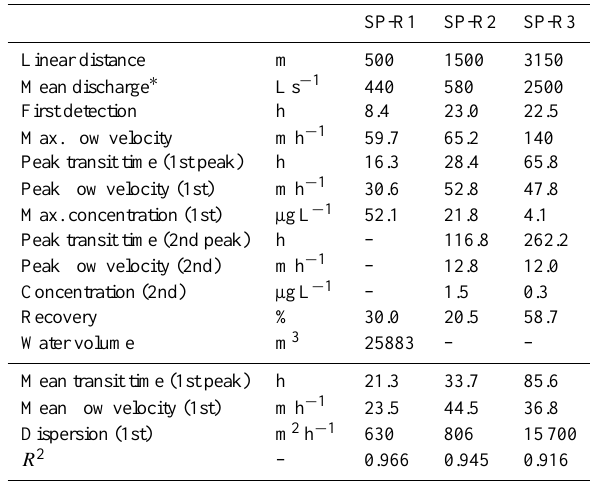
Table 1. Results of the 2011 tracer test in the